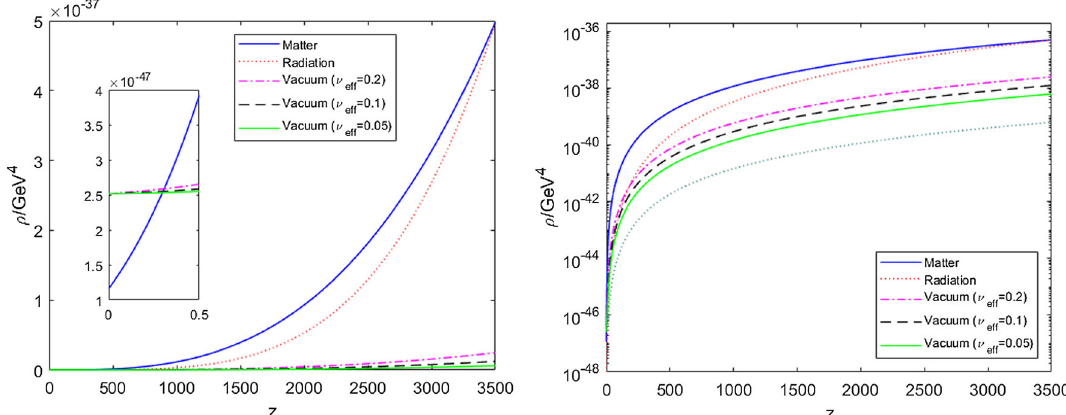
Fig. 2 Evolution of the different energy densities with the expansion in the RVM context. The plot on the right provides a complementary view in a (vertical) logarithmic scale. The VED exhibits a very mild dynamics up to the early radiation dominated epoch. Parameters H 0 and (cid:18) 0 m are taken from the best-fit values of [9–11], see the text. The